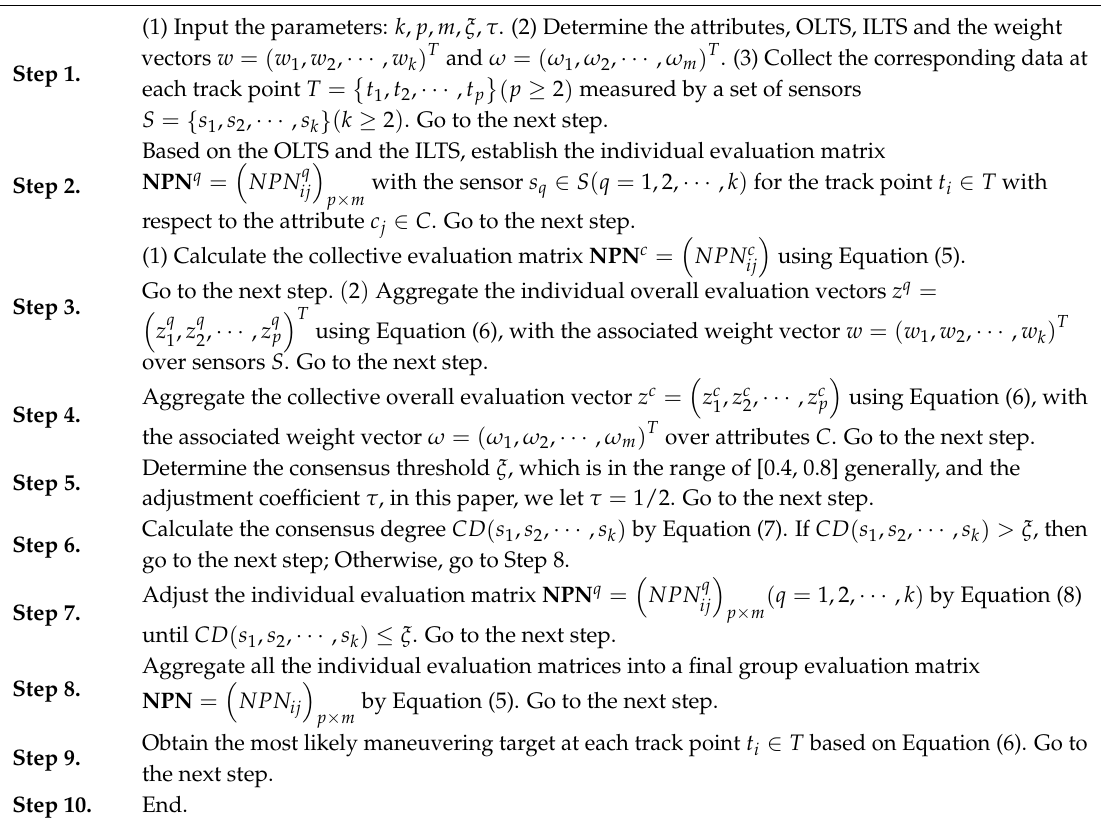
Algorithm 1. The track association algorithm based on consensus model with